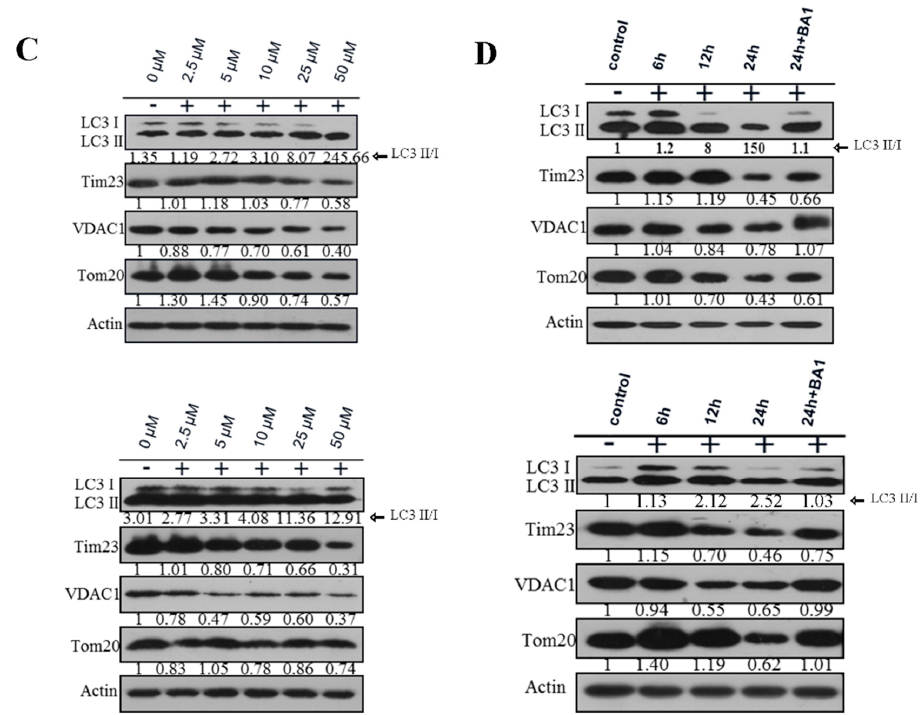
Figure 1. Cisatracurium triggers excessive mitochondrial autophagy in a dose- and time-dependent manner in mammalian cells. ( A ) GFP-LC3 and MitoDsred double fluorescent stable cell line was incubated with cisatracurium (0, 2.5, 5, 10, 25, 50, or 100 µM) for 12 h. GFP-LC3 (green) dot shows autophagosome-like structures. MitoDsred (red) denotes mitochondria. Arrows represent colocalization of LC3-positive autophagosome-like structures with mitochondria. Dotted white frames are enlarged parts of a cell. Bar = 30 µm; ( B ) GFP-LC3 and MitoDsred double fluorescent stable cells were incubated with cisatracurium (5 µM) for 0, 6, 12, or 24 h, in the presence or absence of the lysosome inhibitor Bafinomycin A1 (50 nM, B1793). Arrowheads represent colocalization of LC3-positive autophagosome-like structures with mitochondria. Bar = 30 µm. Arrows indicate colocalized LC3-positive vesicles with mitochondria; ( C ) HeLa ( upper panel) or HUVEC ( lower panel) was incubated with cisatracurium (0, 2.5, 5, 10, 25, or 50 µM) for 12 h. Samples were then subjected to immunoblot using antibodies against LC3, TIM23, TOM20, VDAC, or β -actin. Data are presented as representative images from three independent experiments, and the intensity of indicated bands was measured with ImageJ software and normalized by Beta-actin; ( D ) HeLa ( upper panel) or HUVEC ( lower panel) was incubated with cisatracurium (5 µM) for 0, 6, 12, or 24 h, in the presence or absence of the lysosome inhibitor Bafinomycin A1 (50 nM, B1793). Samples were then subjected to immunoblot using antibodies against LC3, TIM23, TOM20, VDAC, or β -actin. Data are presented as representative images from three independent experiments, and the intensity of indicated bands was measured with ImageJ software and normalized by Beta-actin.